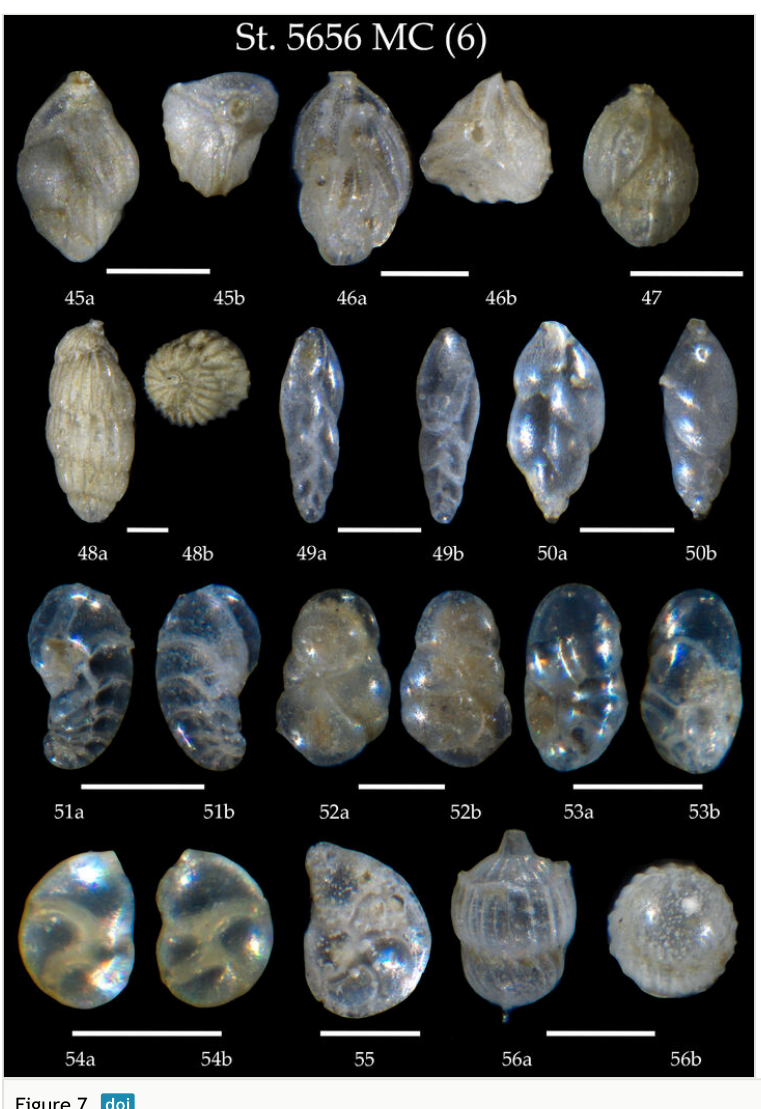
Figure 7. Station 5656 MC (continued). 45 Trifarina angulosa , a side view, b apertural view; 46 Trifarina bradyi , a side view, b apertural view; 47 Uvigerina mediterranea ; 48 Uvigerina peregrina , a side view, b apertural view; 49 Fursenkoina fusiformis , a apertural view, b side view; 50 Fursenkoina complanata , a apertural view, b side view; 51 Geminospira bradyi , a apertural view, b side view; 52 Robertinoides sp., a side view, b lateral view; 53 Robertinoides bradyi , a apertural view, b side view; 54 Neolenticulina variabilis , a side view, b lateral view; 55 Lenticulina gibba ; 56 Amphicoryna scalaris , a side view, b apertural view. Scale 100